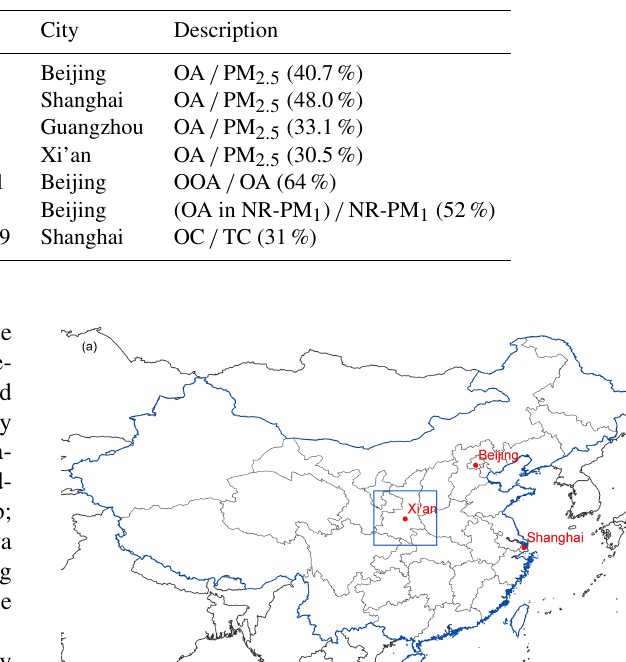
Table 1. Previous results about different OA contributions.